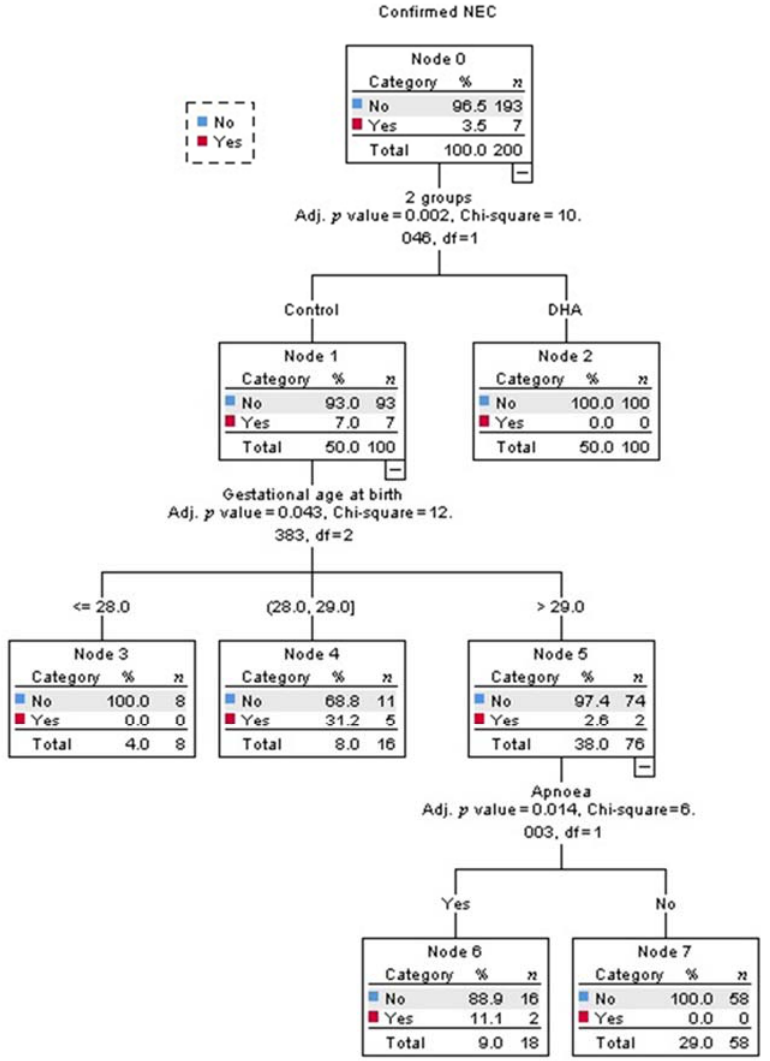
Figure 2. Decision tree obtained from Chi-square automatic interaction detection multiple regression analysis for the prediction of confirmed necrotizing enterocolitis (NEC). The order of the variables, from top to bottom, shows their ranking for the prediction of confirmed NEC; the first was the intervention, the second was gestational age, and the last was presenting apnea.